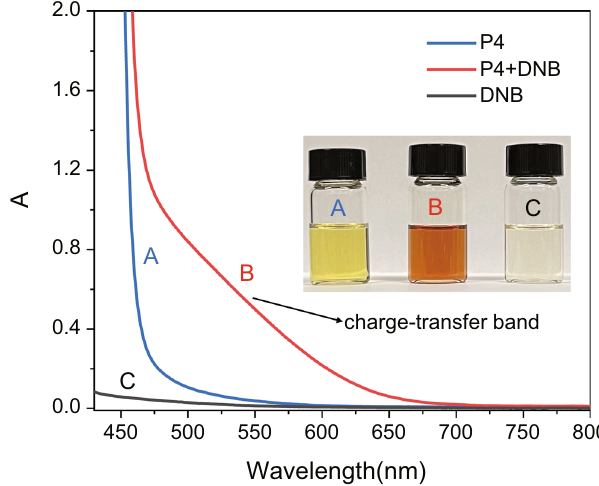
Fig. 3 UV-vis spectra. UV-vis spectra (CHCl 3 ): (A) P4 (3.0 mM); (B) P4 (3.0 mM) and DNB (6.0 mM); (C) DNB (6.0 mM). The inserted optical image shows the solution color change because of the charge-transfer interaction between P4 and